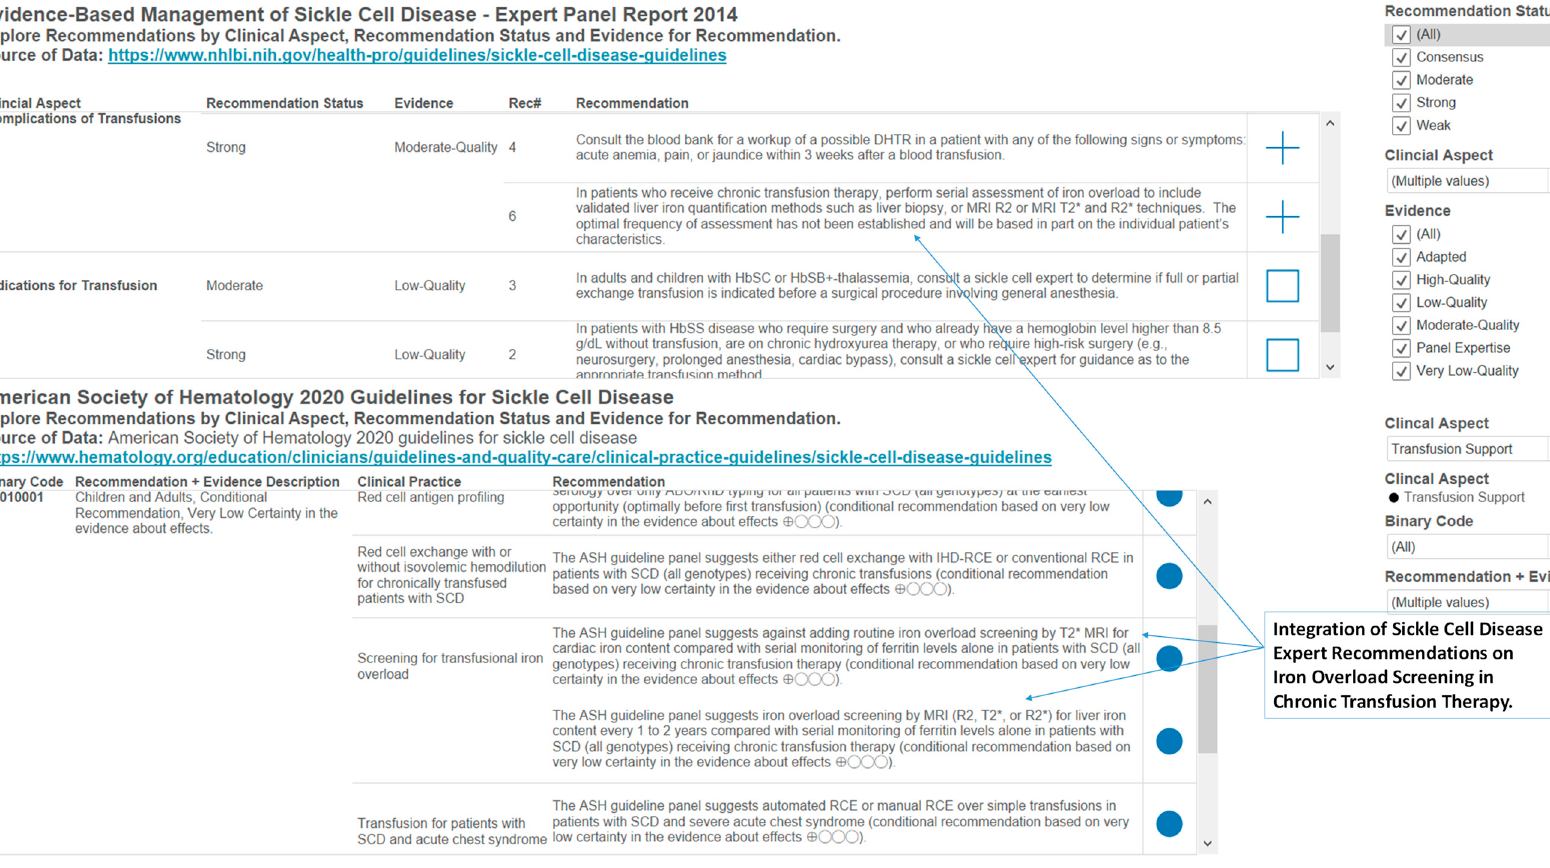
Figure 9. An example design of an interactive visual representation that allows for integrating and comparing expert recommendations on clinical aspects of sickle cell disease. In this example, we highlight the integration of sickle cell disease expert recommendations on iron overload screening in chronic transfusion therapy.